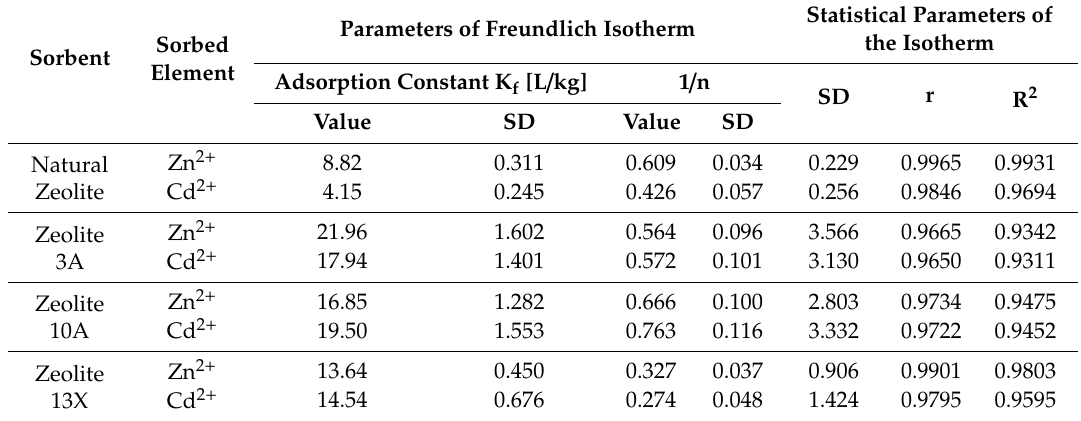
Table 4. The numerical parameters of the determined Langmuir isotherms. Sorbed Element